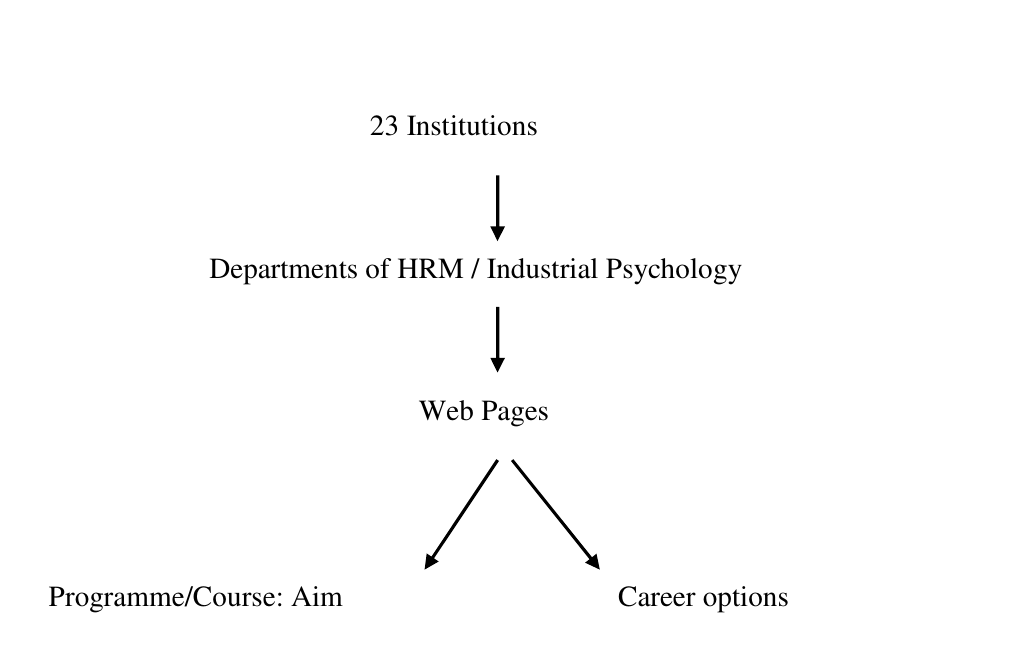
Figure 1: A conceptual framework for examining the aims of Human Resources Management and Industrial Psychology teaching departments, and career options for which their students are equipped